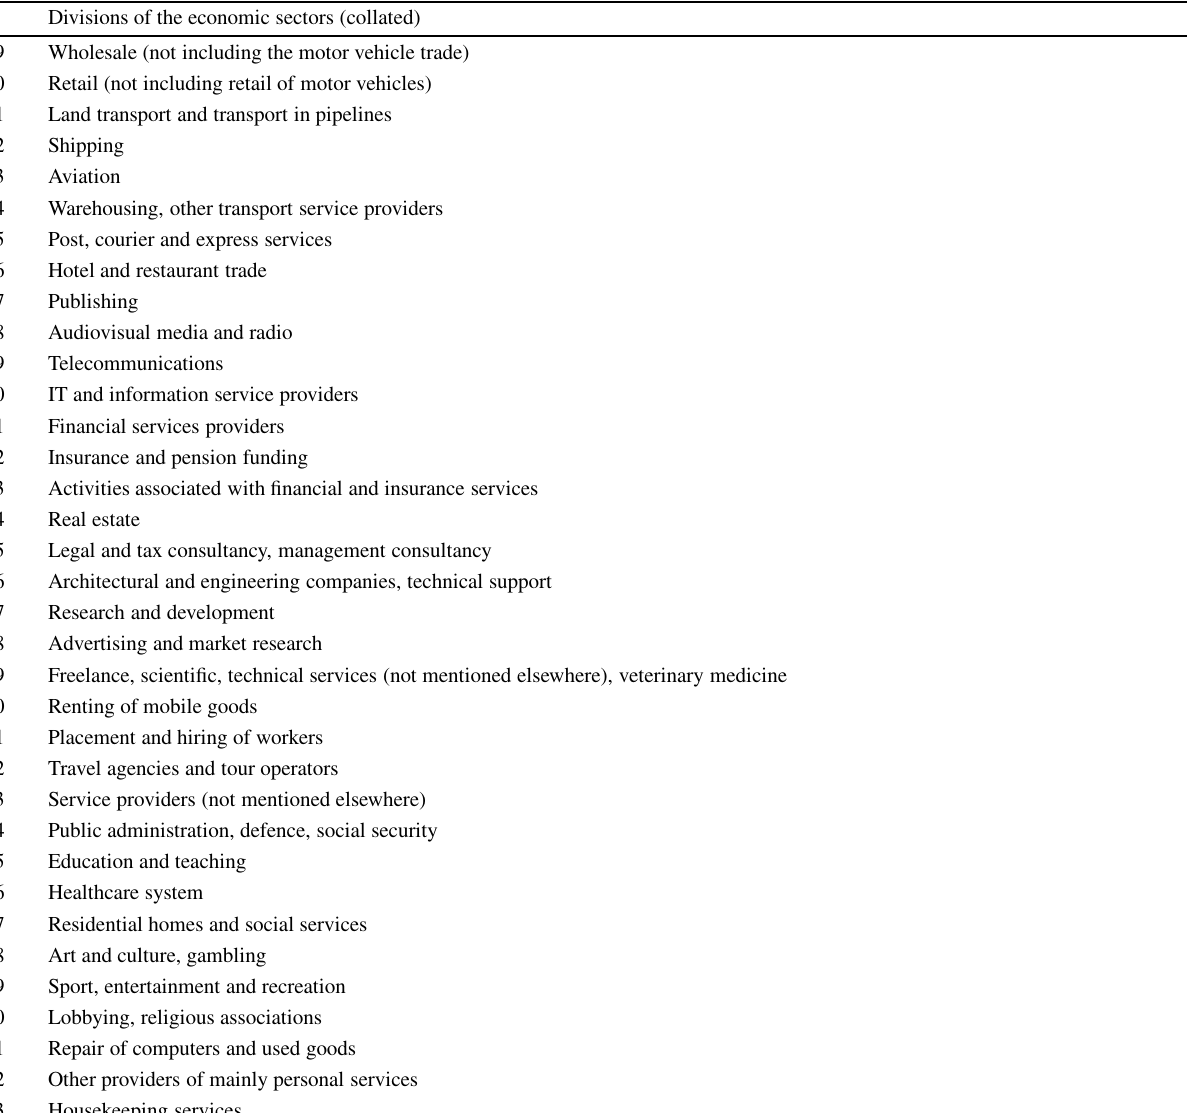
Table 6 Structure of the NACE Rev. 2 Classification of Economic Activities used in the Projection (Continued) Divisions of the economic sectors